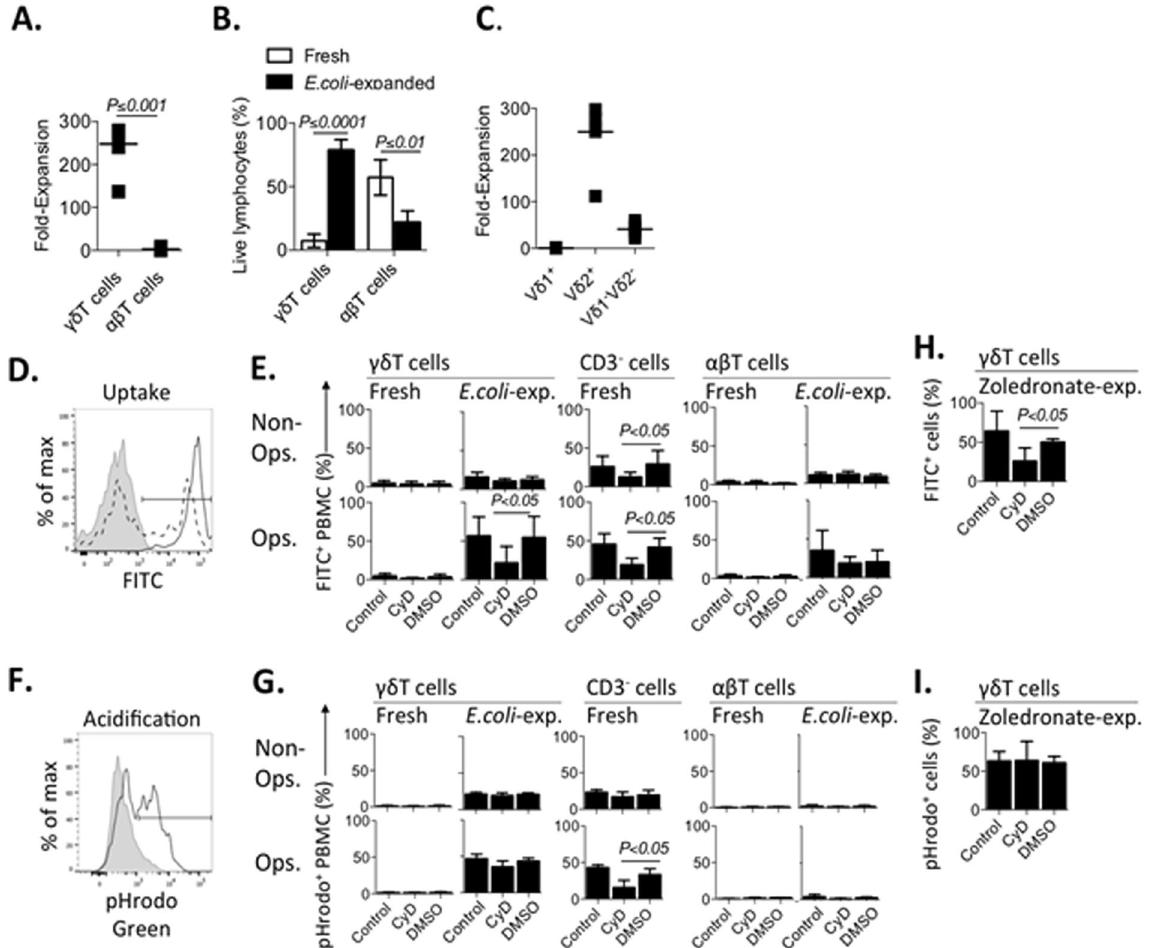
Figure 2. E. coli -expanded, but not fresh, γδ T cells phagocytose IgG-opsonized E. coli . Freshly-isolated PBMC (n = 5) were analyzed for E. coli uptake immediately or stimulated with E. coli , left to expand for 14 days, and examined on day 14. To determine uptake, PBMC were incubated with IgG-opsonized or non-opsonized, fluorescently-labeled E. coli for 60 min. PBMC were pre-cultured with normal media (control), Cytochalasin D (CyD) or DMSO. ( A ) Fold-expansion of γδ T and αβ T cells, assessed by FACS and Trypan Blue exclusion, was compared in 14 day E. coli- stimulated PBMC. ( B ) PBMC were compared via FACS for γδ T and αβ T cell content of total live lymphocytes. ( C ) Fold-expansion in response to E. coli over 14 days was compared between γδ T cell subsets. ( D ) PBMC were incubated with FITC-labeled E. coli and quenched post-culture with Trypan Blue. Shown are representative stains, gated on γδ T cells: i) non-quenched co-culture indicating total FITC fluorescence (black, solid, unshaded), ii) quenched co-culture indicating intracellular FITC fluorescence (black, dotted, unshaded), iii) co-culture with non-FITCylated E. coli (gray, shaded). ( E ) The proportion of FITC pos PBMC was examined. ( F ) PBMC were incubated with pHrodo-labeled E. coli . Shown are representative stains: i) PBMC, gated on γδ T cells, co-cultured with pHrodo- E. coli (black, solid, unshaded), ii) pHrodo- E. coli only control (gray, shaded). ( G ) The proportion of pHrodo pos PBMC was examined. ( H ) Uptake of IgG-opsonized FITC- E. coli and ( I ) acidification of IgG-opsonized pHrodo- E. coli was examined in 14 day zoledronate- expanded γδ T